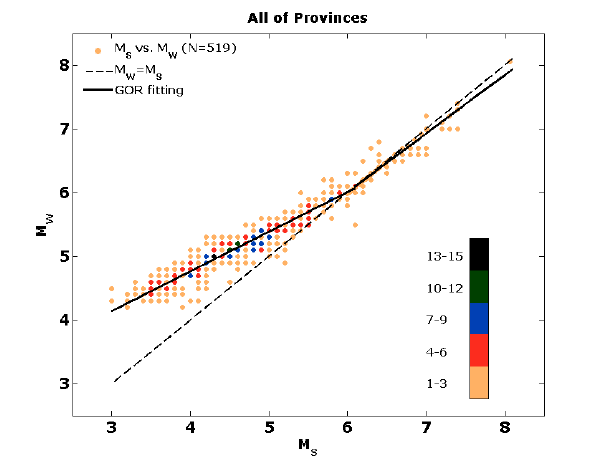
Figure 4. Bilinear regression is the best fit for M